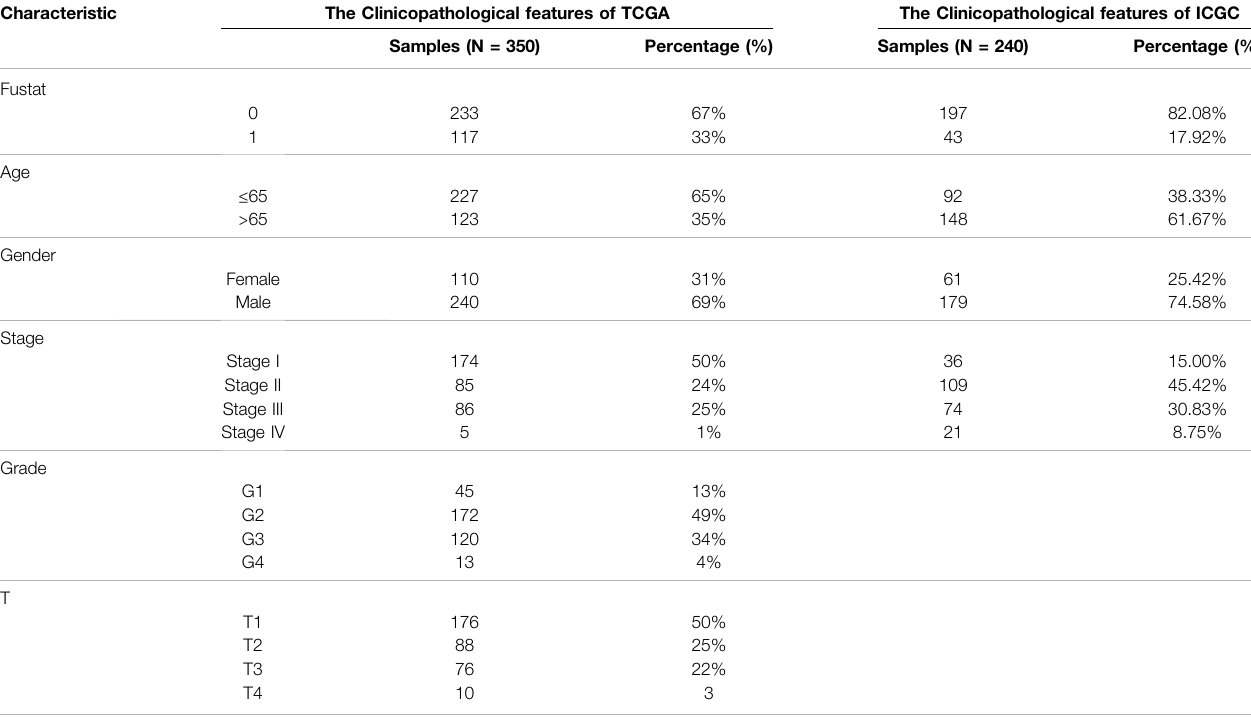
TABLE 1 | Clinical information of the two cohorts.